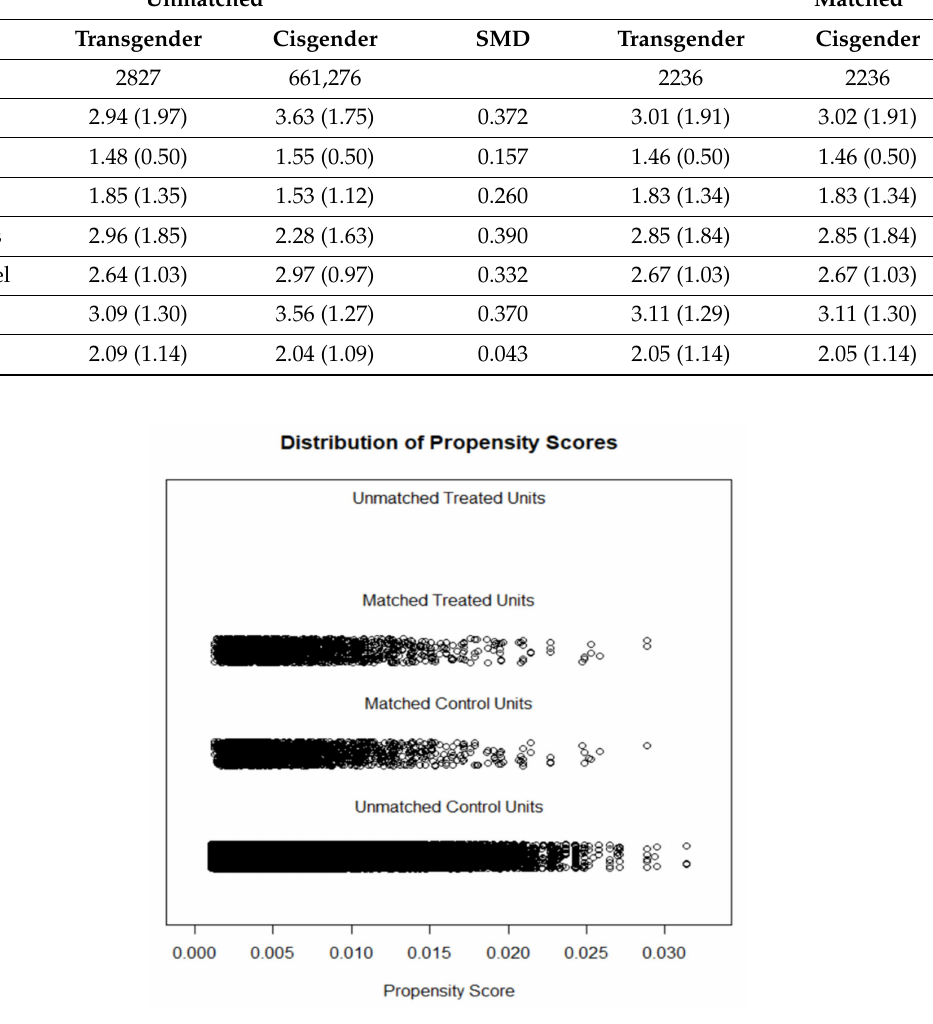
Figure 1. Jitter plot displaying propensity score